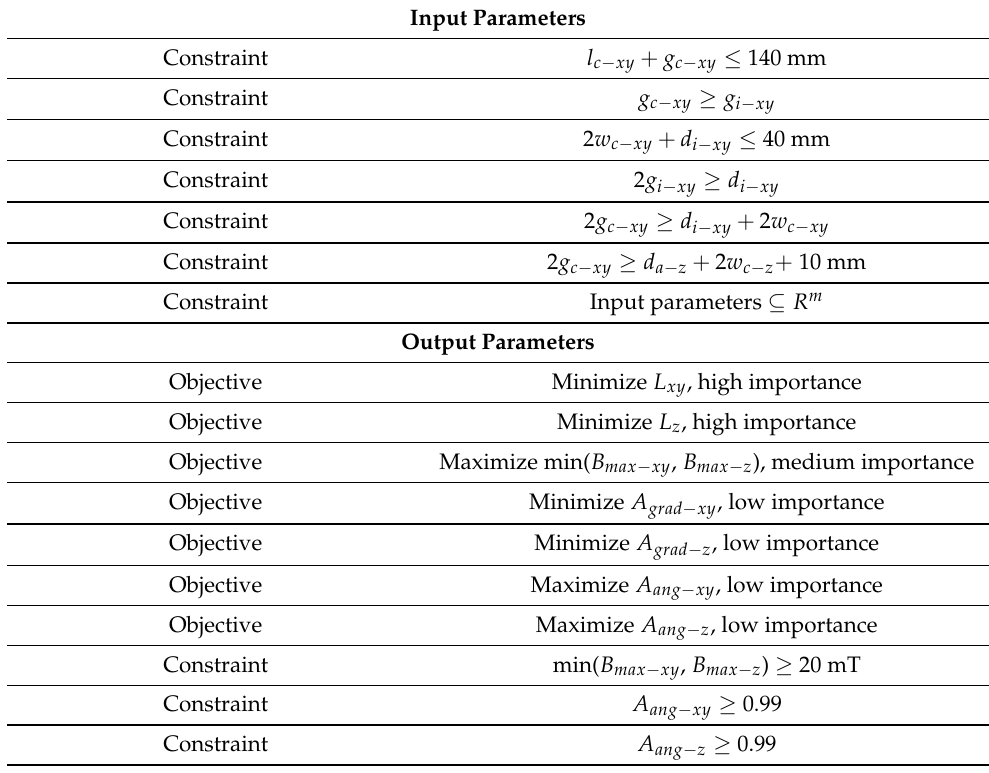
Table 1. Optimization objectives and constraints.